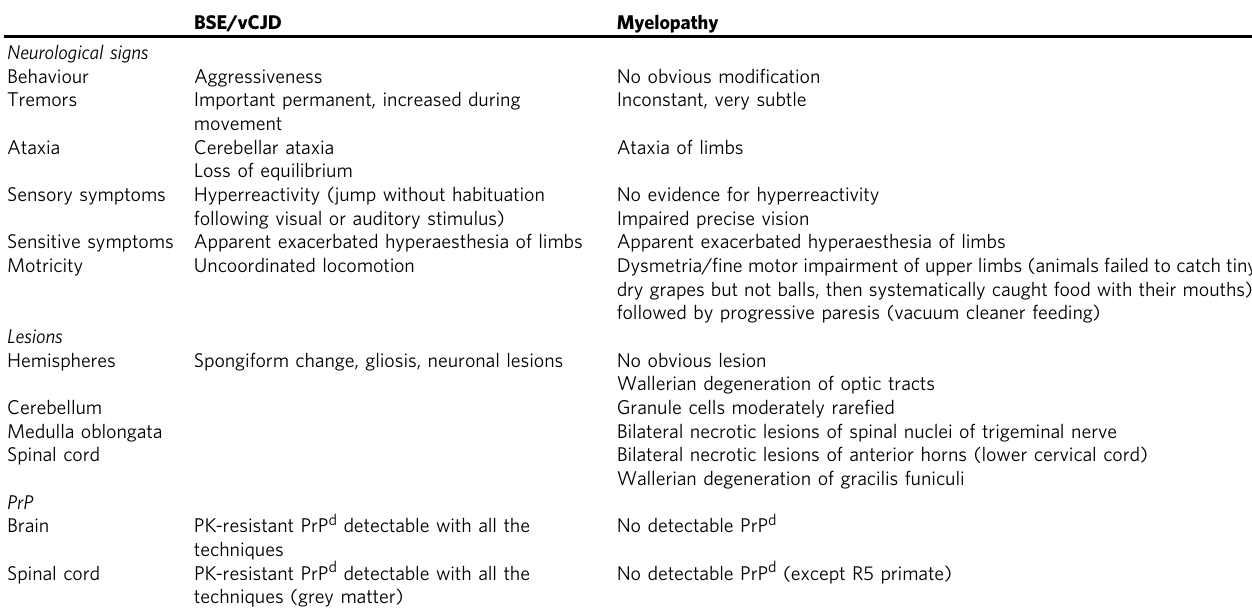
Table 1 Comparison of neurological signs, pathological and biochemical features of the BSE/vCJD vs. myelopathic syndrome in